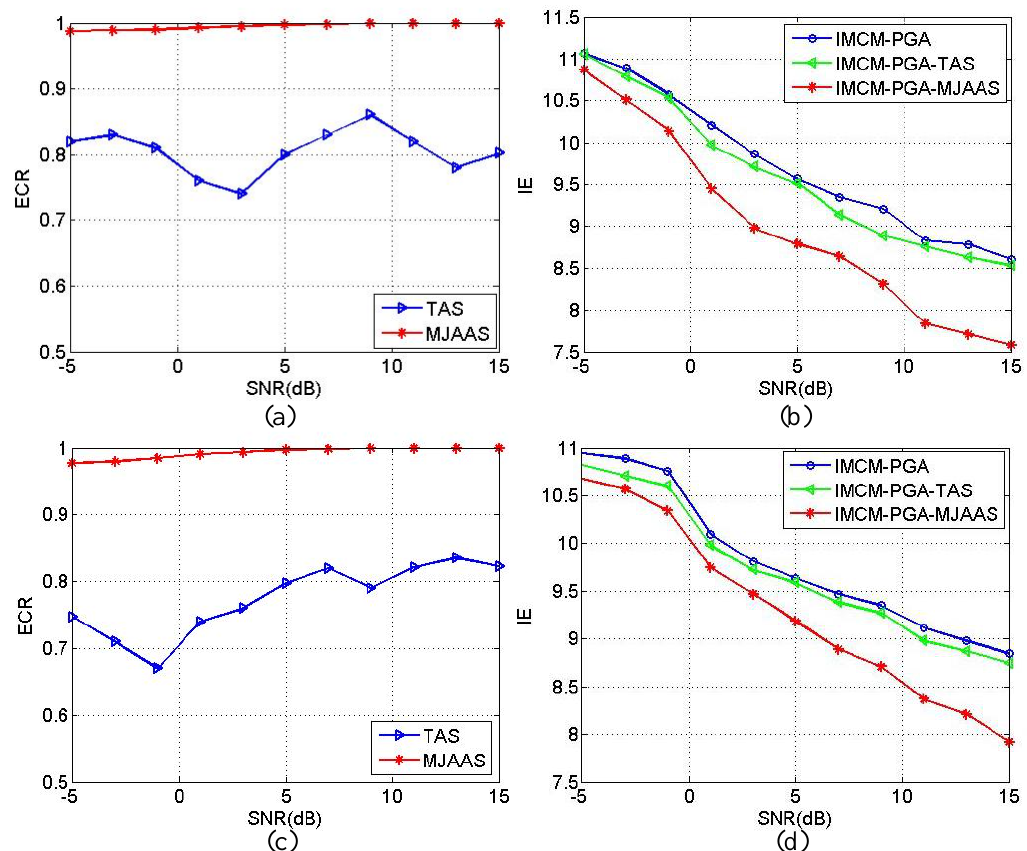
Figure 8. The relationship curves between ECR and SNR and the relationship curves between IE and SNR corresponding to CM and NCM. CM: ( a ) ECR; ( b ) IE. NCM: ( c ) ECR; ( d )